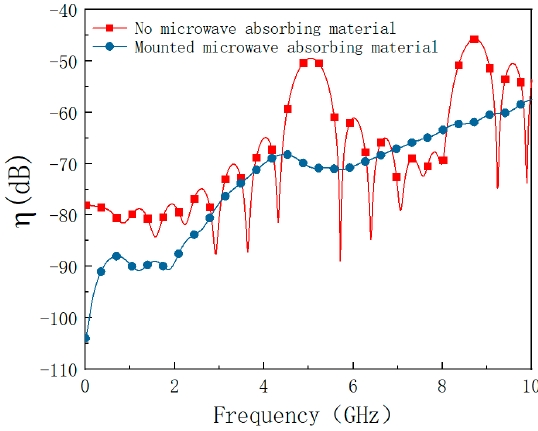
Figure 11. Coupling coefficient before and after mounting absorbing material under UWB.